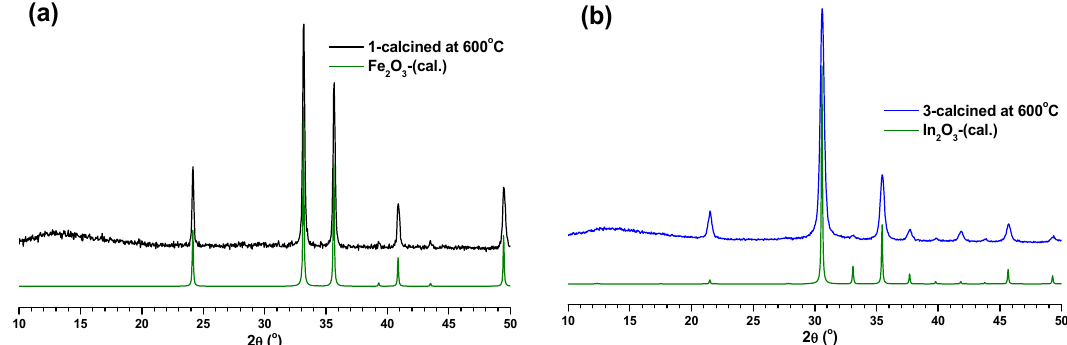
Figure 3. Comparison of PXRD patterns of 1 ( a ) and 3 ( b ) calcined at 600 °C with calculated PXRD pattern of their respective metal oxides.